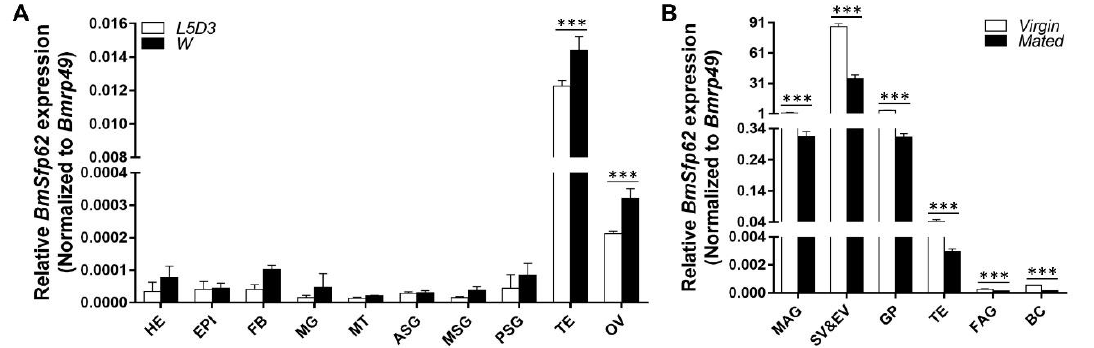
Figure 2. BmSfp62 is highly expressed in testis. ( A ) BmSfp62 expression in 10 tissues: head (HE), epidermis (EPI), fat body (FB), midgut (MG), Malpighian tubules (MT), anterior silk gland (ASG), middle silk gland (MSG), posterior silk gland (PSG), testis (TE) and ovary (OV) at L5D3 and W stages.